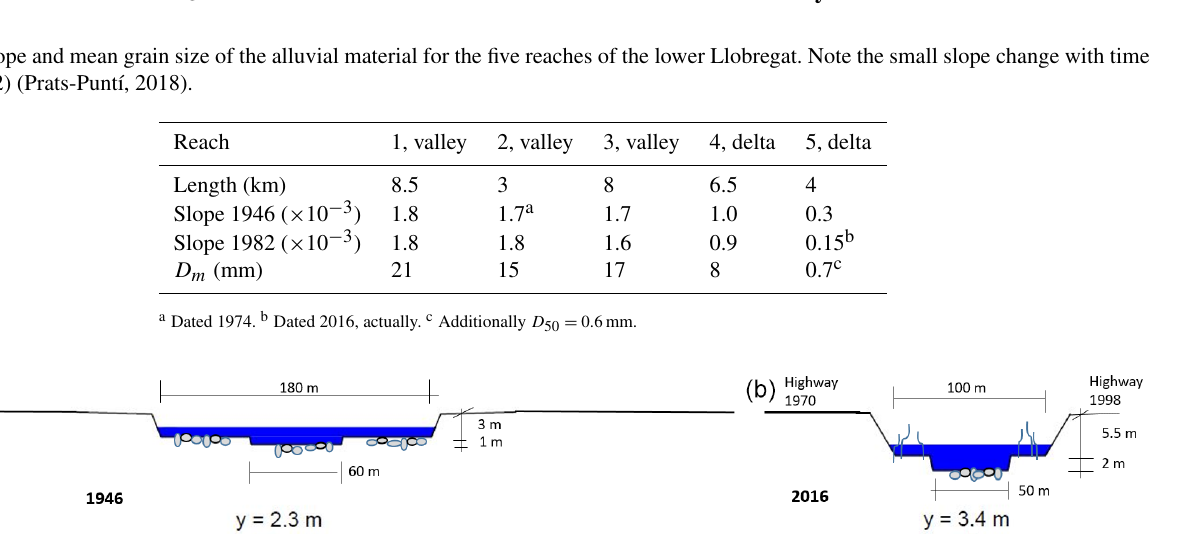
Figure 6. Cross sections of reach 1 for the two extreme dates, 1946 (a) and 2016 (b) . Alluvial widths are 175 and 33m, respectively (Table 4, later). Depth y drawn in the cross sections corresponds to a discharge of 600m 3 /s, within the first day of the flow duration curve.